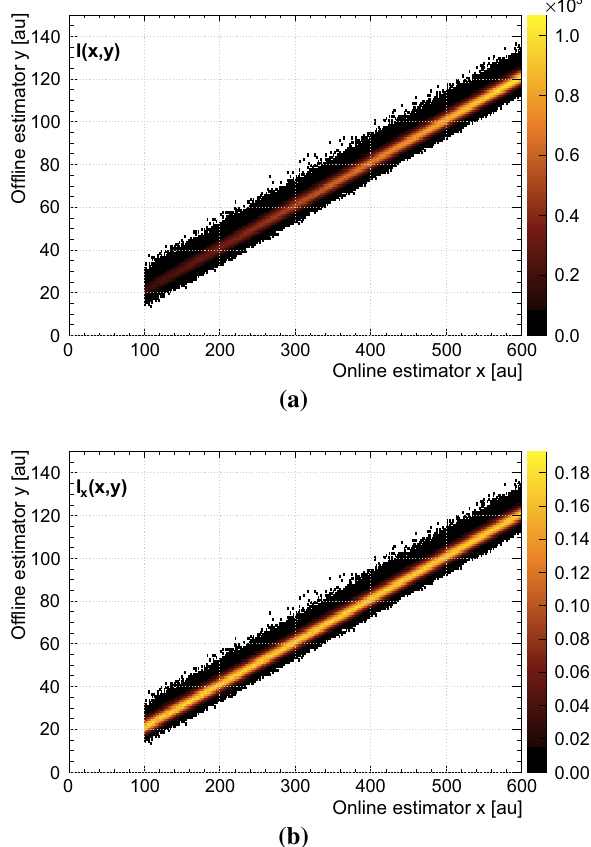
Fig. 1 Simulated data using a skewed Gaussian resolution function with μ = 0 . 2 x , σ = 0 . 2, and λ = 0 . 7 (see Eq. (10)). The spectrum is I ( x ) = 10 x . a The I ( x , y ) distribution as it might be measured in an experiment. b The I x ( x , y ) distribution, where each bin in I ( x , y )